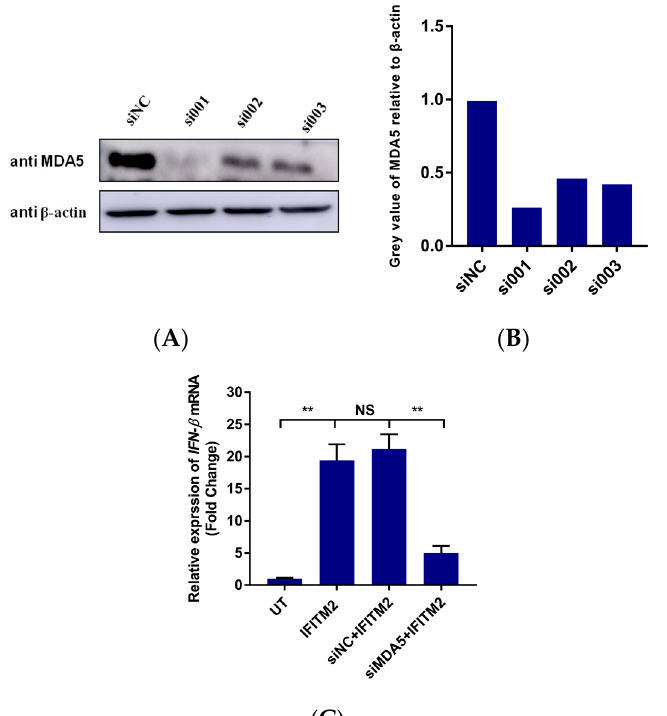
Figure 8. ( A ) 150 nM siRNA targeting MDA5 was transfected into HEK293 cells. Cells were collected 24 h post-transfection,. Cellular protein was extracted via RIPA and subjected to SDS-PAGE. Western blotting was performed for MDA5 expression by using a specific antibody. β -actin served as a loading control. ( B ) Greyscale analysis was used to measure the MDA5 expression level relative to β -actin. ( C ) HEK293 cells were transfected with 150 nM MDA5 siRNA. This was performed 24 h post − transfection, followed by transfecting with pCMV − Myc − IFITM2 (1 µg) for another 24 h. Cells were collected for cellular total RNA extraction. RT-qPCR was performed for IFN- β mRNA detection. All values were normalized to the level of β− actin mRNA. Data were expressed as mean ± SDs from three independent experiments and were measured in technical duplicate. Comparisons between groups were performed using the Student’s t − test. ** p < 0.01.